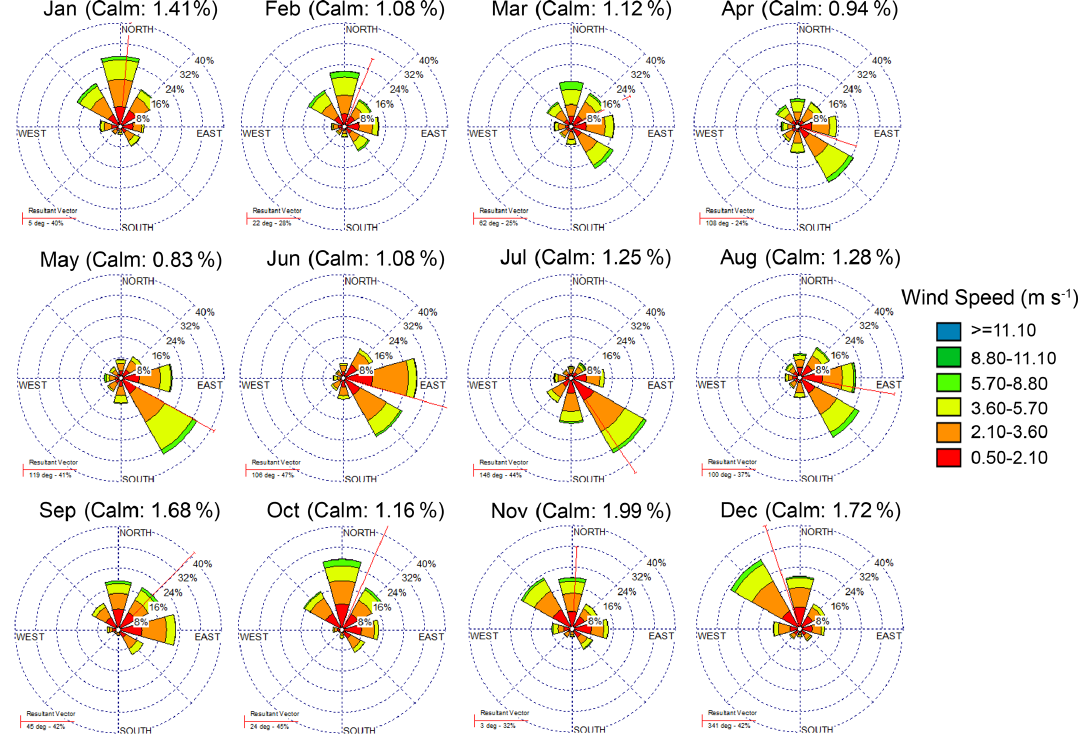
Figure 2. Monthly wind rose diagrams averaged over the period of 2012 to 2017 at Dongtan (DT) site, a remote rural site near Sheshan Island